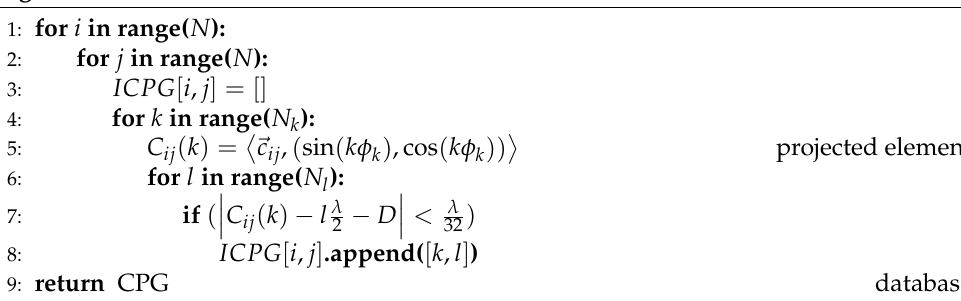
Algorithm 1 Generation of the ICPG database